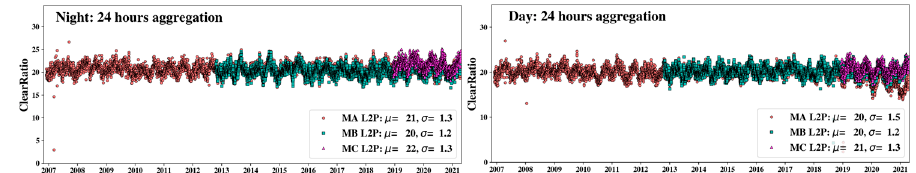
Figure 18. Time series of 24hr aggregated ( left ) night and ( right ) day clear-sky fractions (in %). 6. Latitudinal Hovmöller Diagrams of Biases with Respect to (D + TM)